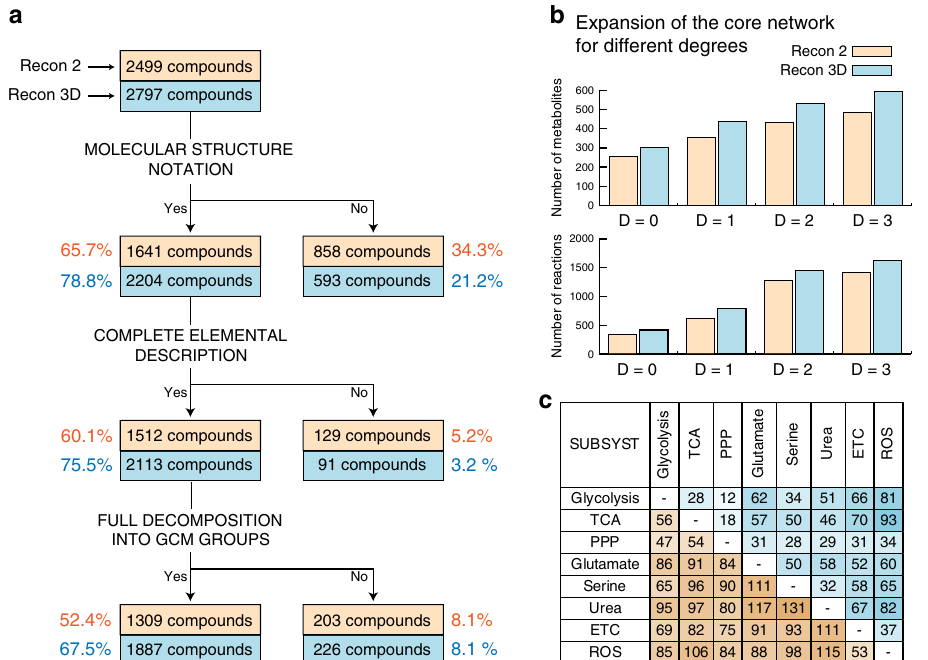
Fig. 2 Thermodynamic curation of human GEMs. a Thermodynamics for the unique compounds in Recon 2 (orange) and Recon 3D (blue). The percentage is relative to the total number of unique compounds. b Size of the core network when the expansion is performed for different degrees. c Number of reactions that pairwise connect the subsystems for Recon 2 (values below the diagonal) and Recon 3D (values above the diagonal) for degree D =